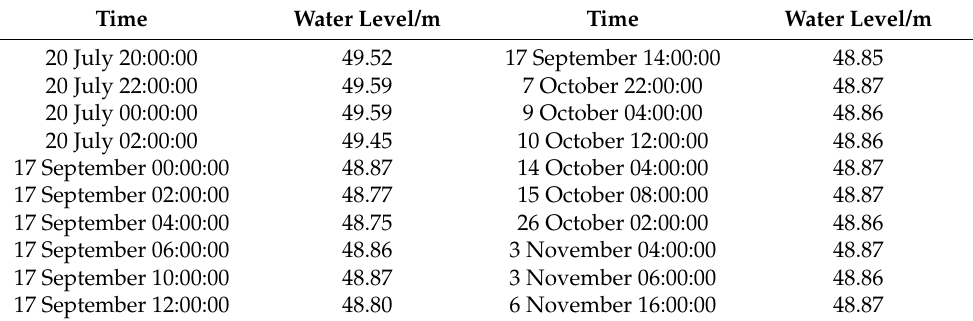
Table 2. Outliers in the monitoring data.